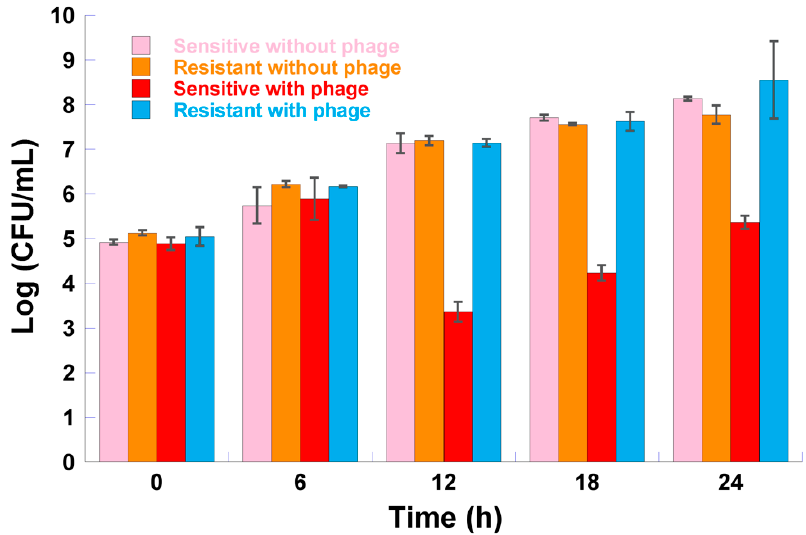
Figure 7. P. syringae pv. syringae concentration of resistant mutants versus their sensitive cells in the presence or absence of phage φ 6 at a multiplicity of infection (MOI) of 1 after 6, 12, 18, and 24 h of incubation. Values represent the mean of three independent assays; error bars represent the standard deviation.